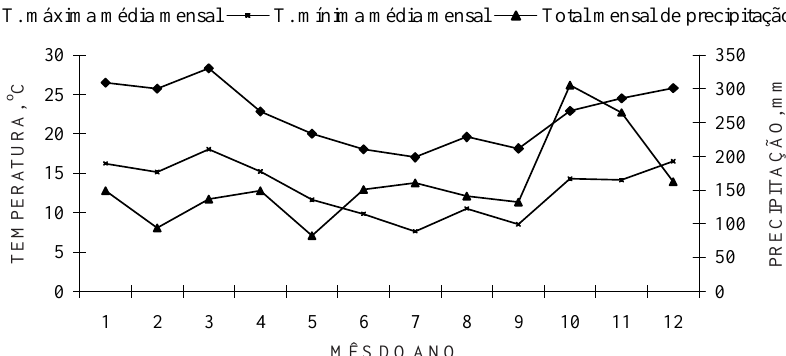
Figura 1. Média mensal de temperaturas (máxima e mínima) e total mensal de precipitação, registrados pela Estação Metereológica da EPAGRI de Lages (SC), no período de janeiro a dezembro de